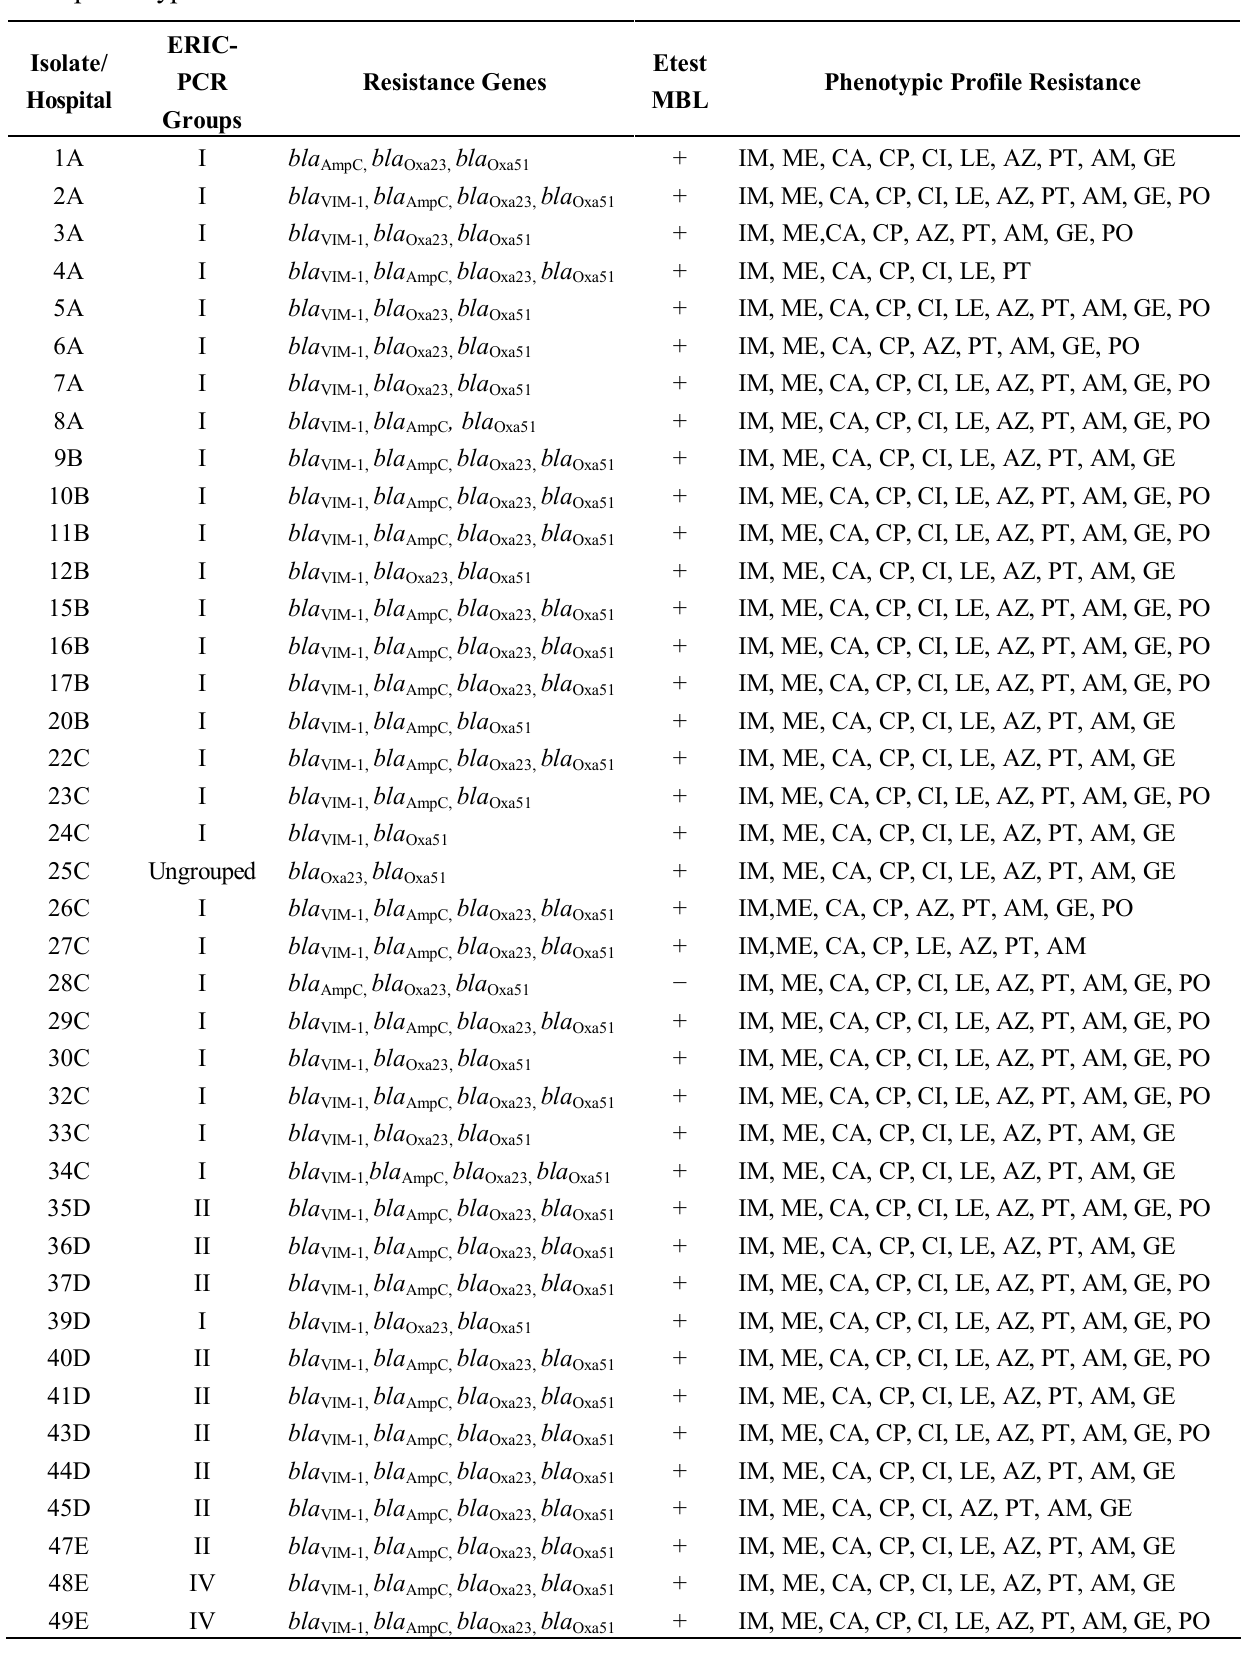
Table 3. Profiles obtained by ERIC-PCR,  -Lactamase results and antimicrobial resistance phenotypes in evaluated A. baumannii strains.